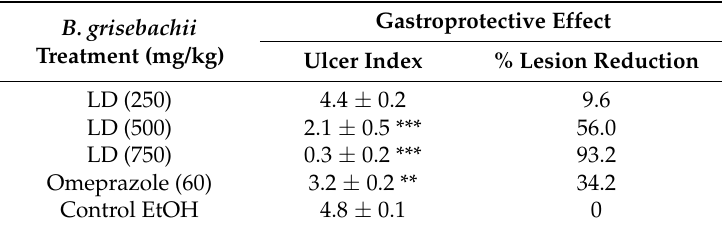
Table 2. Gastroprotective effect of B. grisebachii LD on ethanol induced gastric lesions in rats.